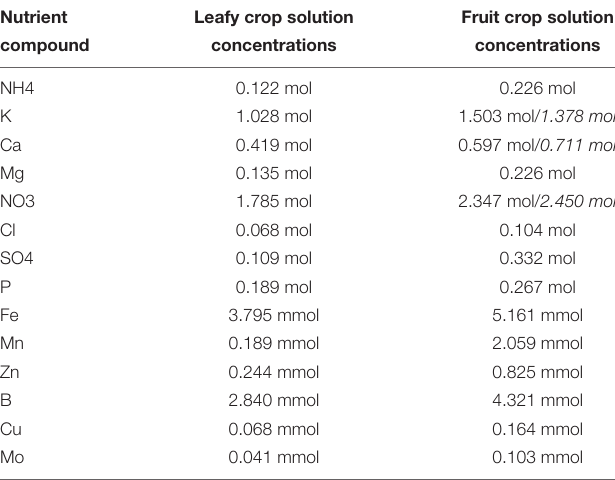
TABLE 2 | Nutrient concentration in 100 L bulk solution in NDS tanks during the experiment phase. Nutrient Leafy crop solution Fruit crop